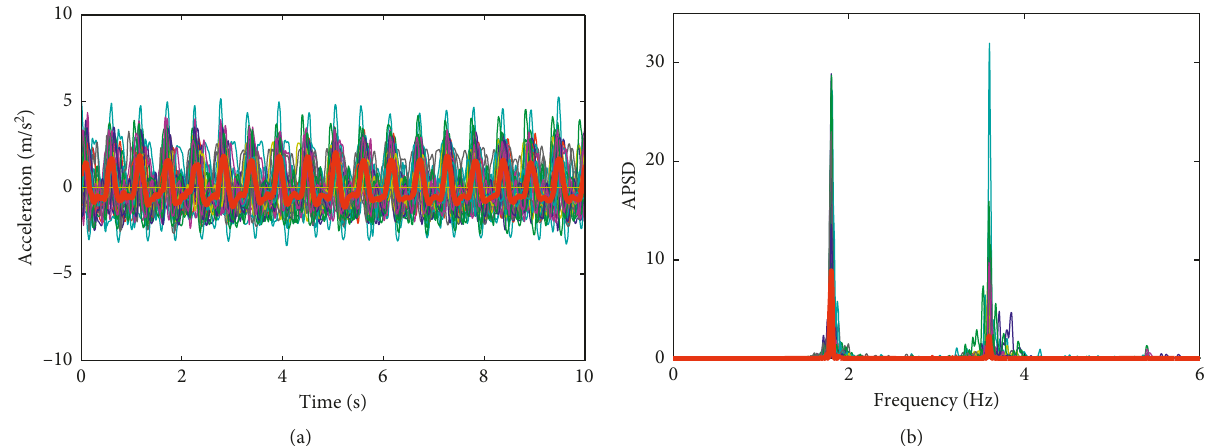
Figure 12: Time histories of the synchronous acceleration (thick red line) and the individual accelerations for the reference load case at 1.8Hz. (a) Time histories; (b) autopower spectral density.